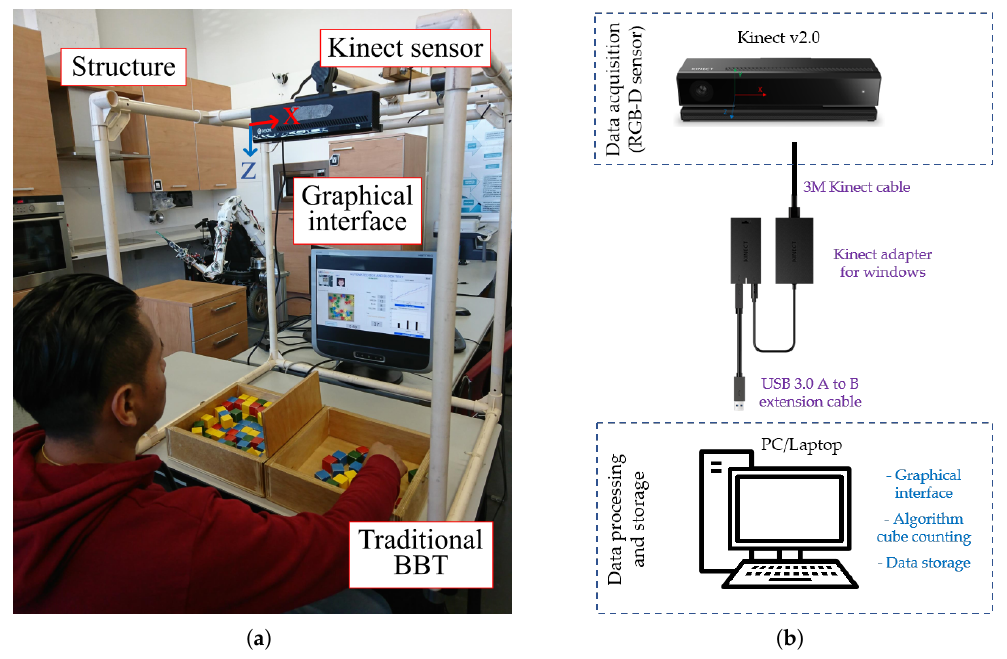
Figure 2. The Automated Box and Blocks Test. ( a ) Components: Kinect sensor (at the top of the portable structure), the BBT box, and the graphical Interface to allow the automatic test administration; ( b ) hardware